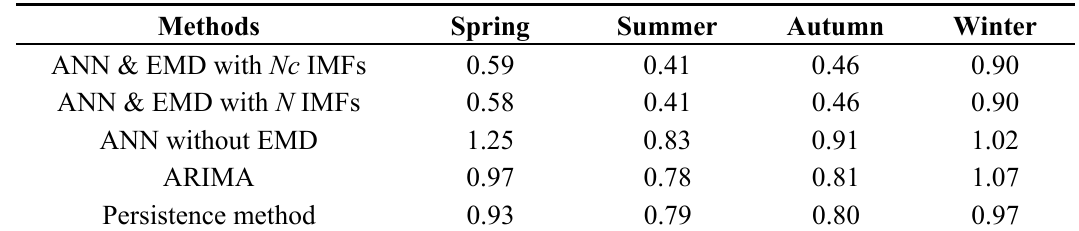
Table 4. MAE of forecasted wind speed (m/s) obtained by various methods.